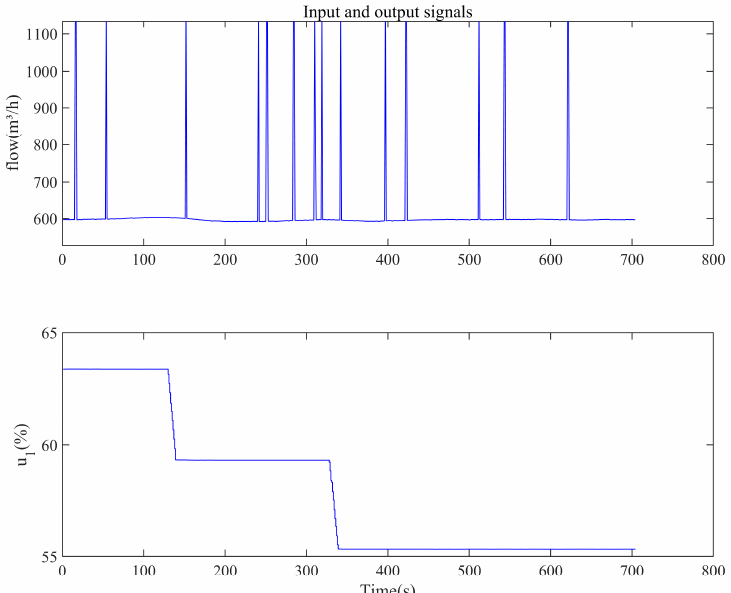
Figure 5. Feedback of solenoid valve DN400 and electromagnetic flowmeter.